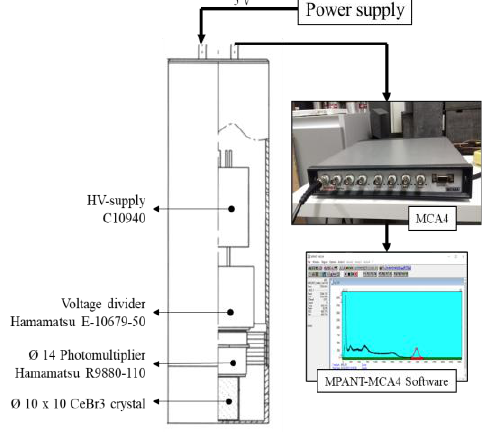
Figure 5 – Simple schematic of detector assembly and experimental detection system used for the preliminary desk